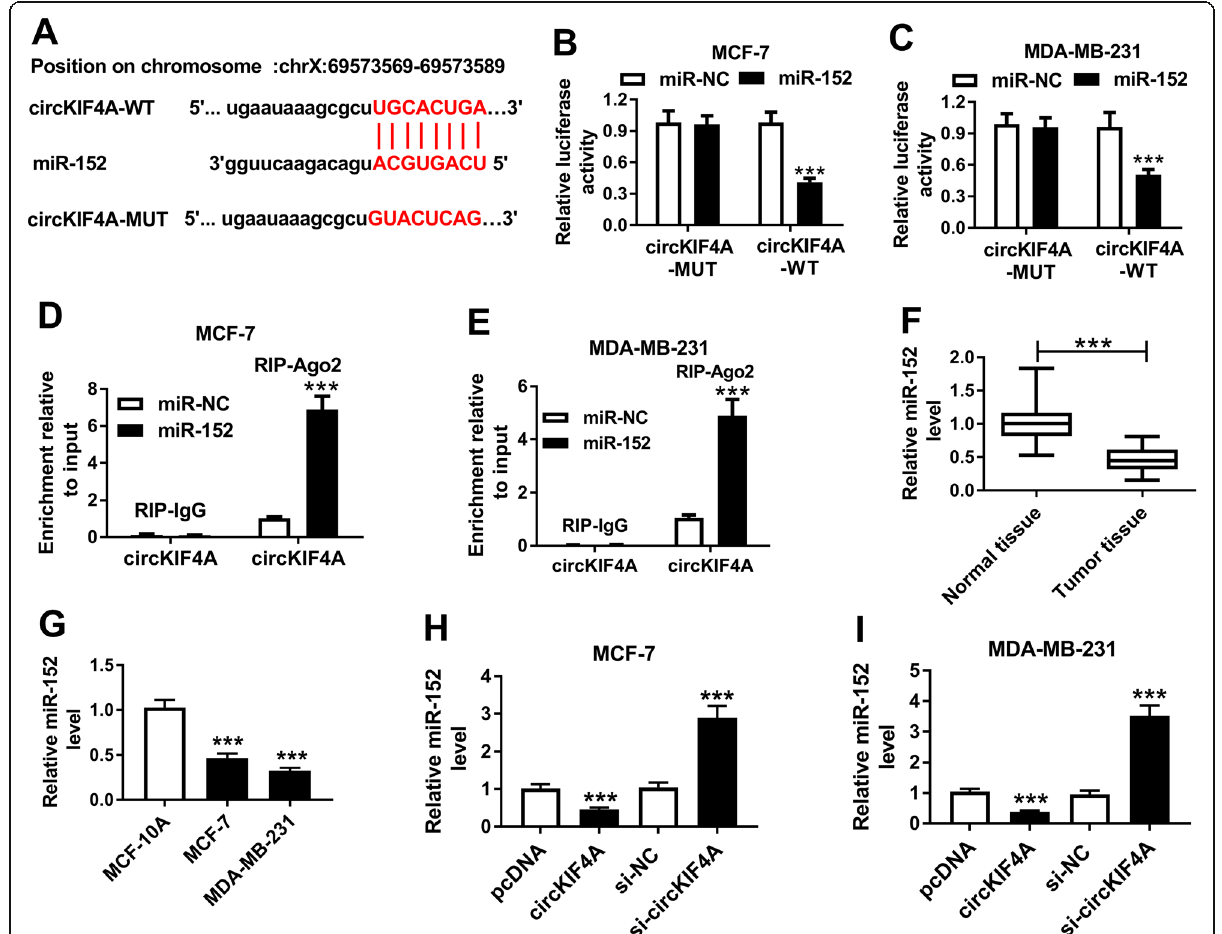
Fig. 3 CircKIF4A interacted with miR-152 and negatively regulated its expression. ( a ) The putative binding sequences between circKIF4A and miR- 152 were shown. ( b and c ) The association between circKIF4A and miR-152 was analyzed using dual-luciferase reporter assay. ( d and e ) RIP and qRT-PCR assays were performed to measure the binding efficiency of circKIF4A and miR-152 to Ago2 or IgG in MCF-7 and MDA-MB-231 cells. ( f and g ) The expression of miR-152 in BC tissues and cells was determined by qRT-PCR. ( h and i ) The level of miR-152 in BC cells transfected with pcDNA-circKIF4A or si-circKIF4A or their controls was detected by qRT-PCR. ***P <